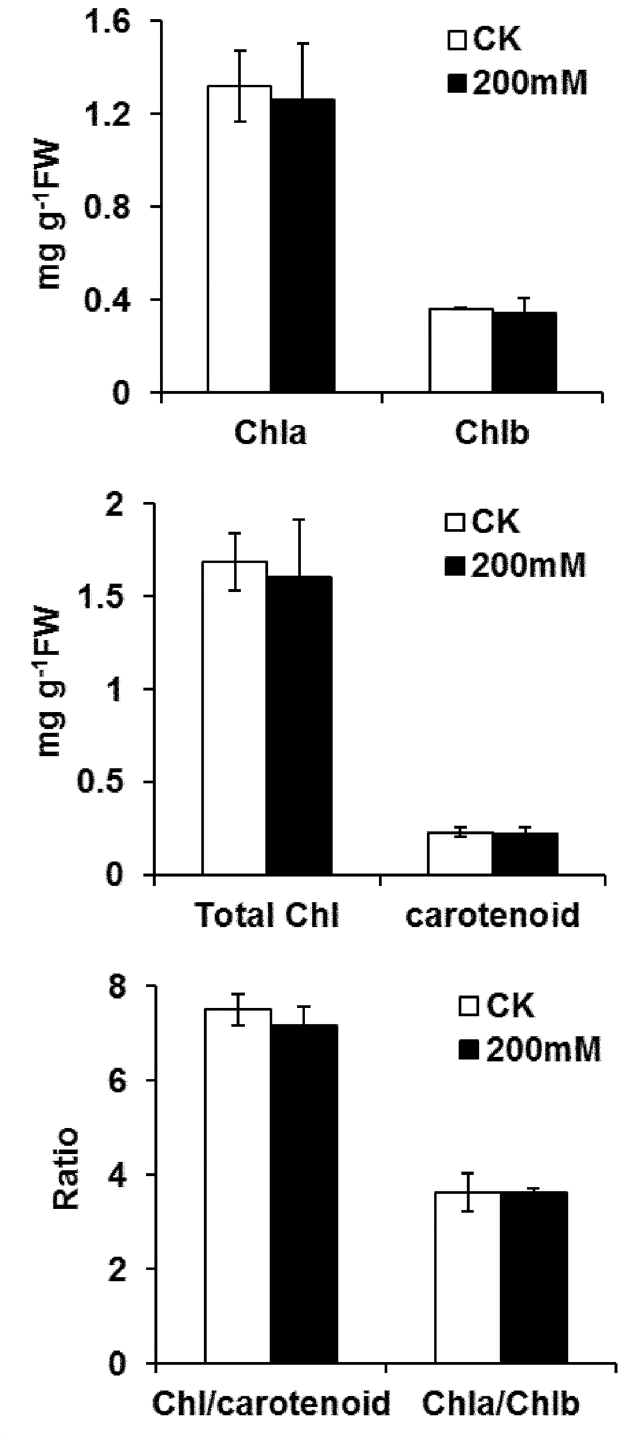
Fig 2. Effect of salt-stress treatments on pigments in B . napus ‘ Nannongyou No. 3 ’ . Values shown are means ± SD from three biological replicates.